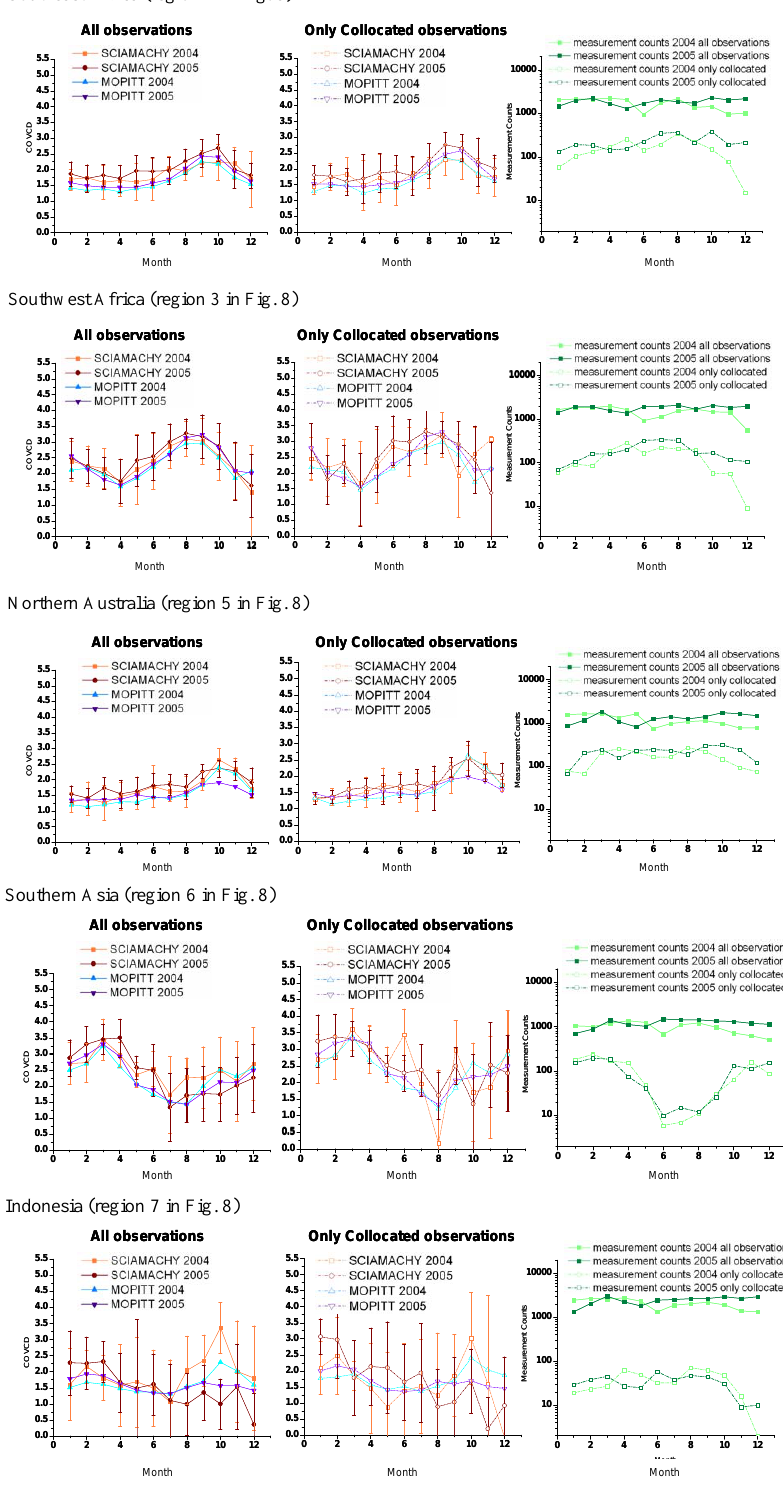
Fig. A5 Comparison of the monthly mean CO VCD (in units of 10 18 molec/cm 2 ) derived from SCIAMACHY and MOPITT. In the left column of the figure all measurements within the selected regions (see Fig. 6) are considered. In the middle column only collocated and coincident observations are used. The error bar of SCIAMACHY refers to the unbiased estimator of a weighted population variance. In the right column the number of selected observations are indicated (please notice the logarithmic scale).